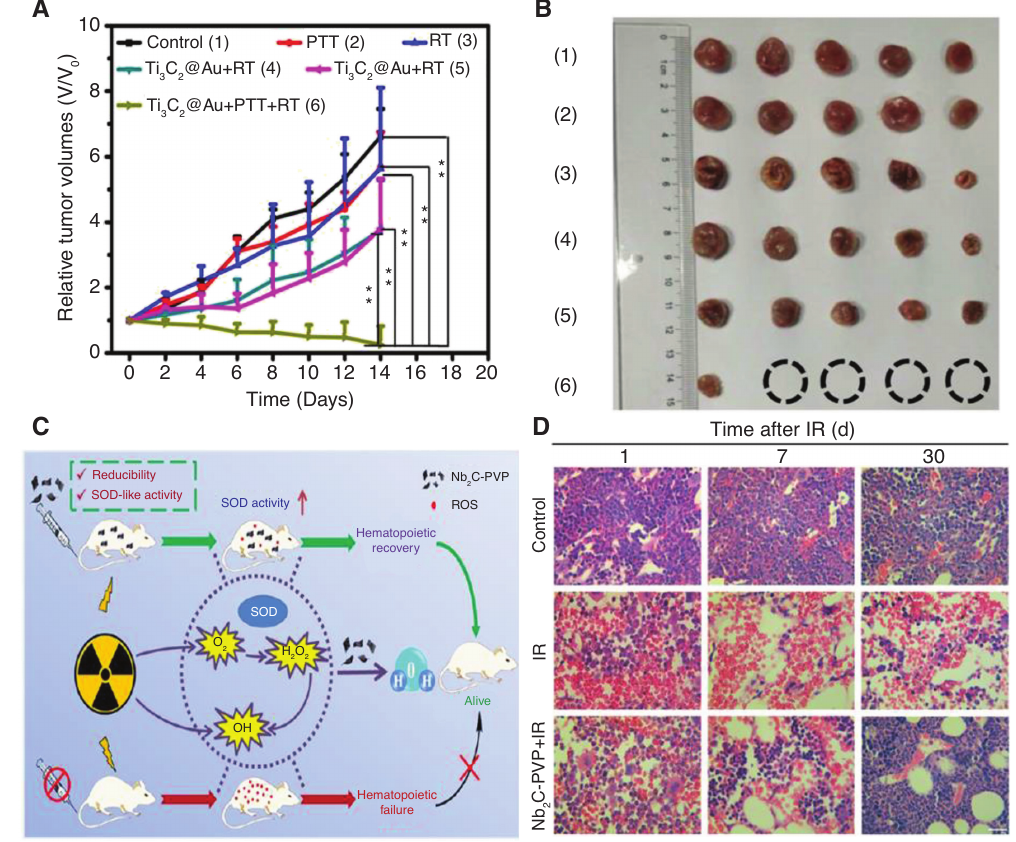
Figure 8: Other combined therapy strategies of cancer. (A) Tumor volume growth curves of mice after various treatments (n = 5). NIR irradiation was conducted by 1064 nm laser at 0.75 W cm −2 for 10 min, whereas the dose for RT was 6 Gy [99]. (B) Photographs of tumors harvested from mice 14 days after the treatments [99]. (C) Detailed mechanism diagram of 2D-Nb C-MXene as a radiation protective agent [107]. (D) In vivo evaluation of radiation protection by 2 Nb C-PVP on IR-induced multiple organ degeneration 2